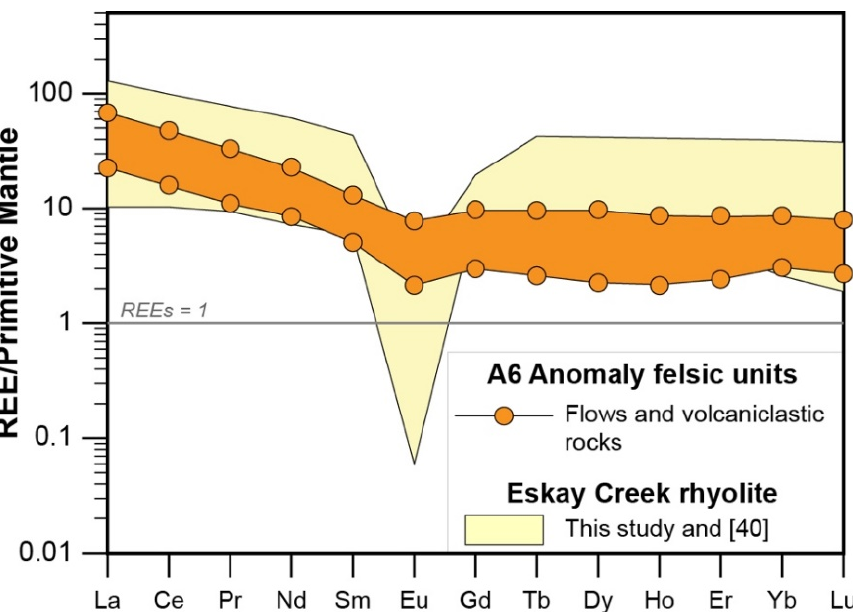
Figure 9. Spider diagram of REEs normalized to primitive mantle [58] for felsic units at the A6 Anomaly (orange) and Eskay Creek rhyolite (light yellow, [40] and this study).